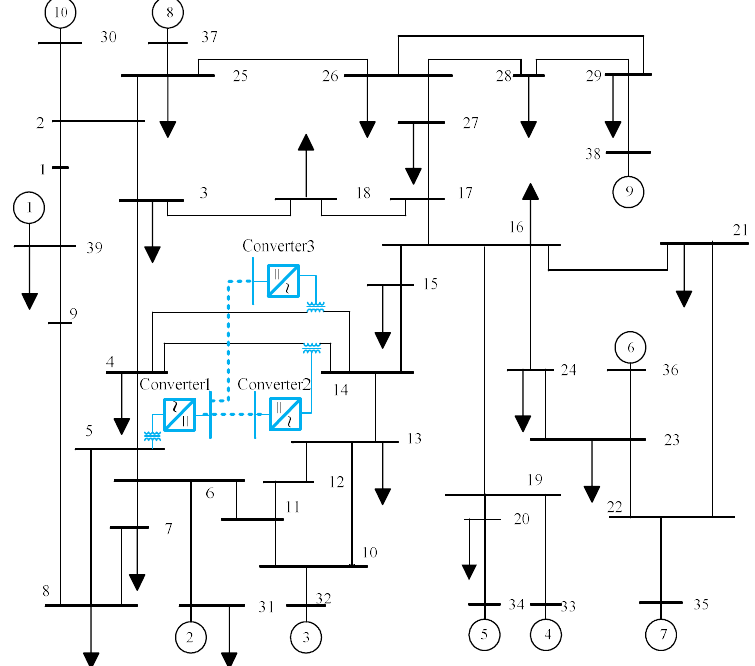
Figure 8. The Institute of Electrical and Electronics Engineers (IEEE) 39-bus test system with a novel structure UPFC.